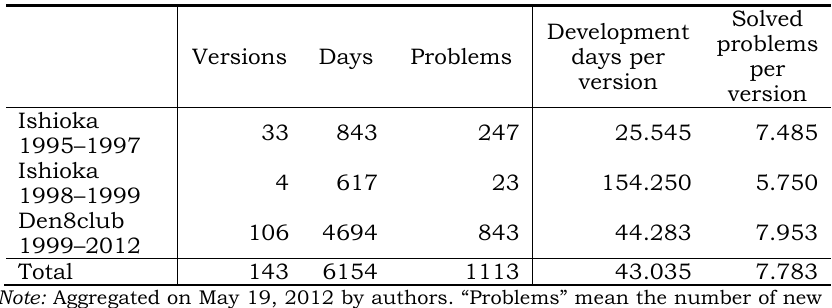
Table 2. The history of Denshin 8 go